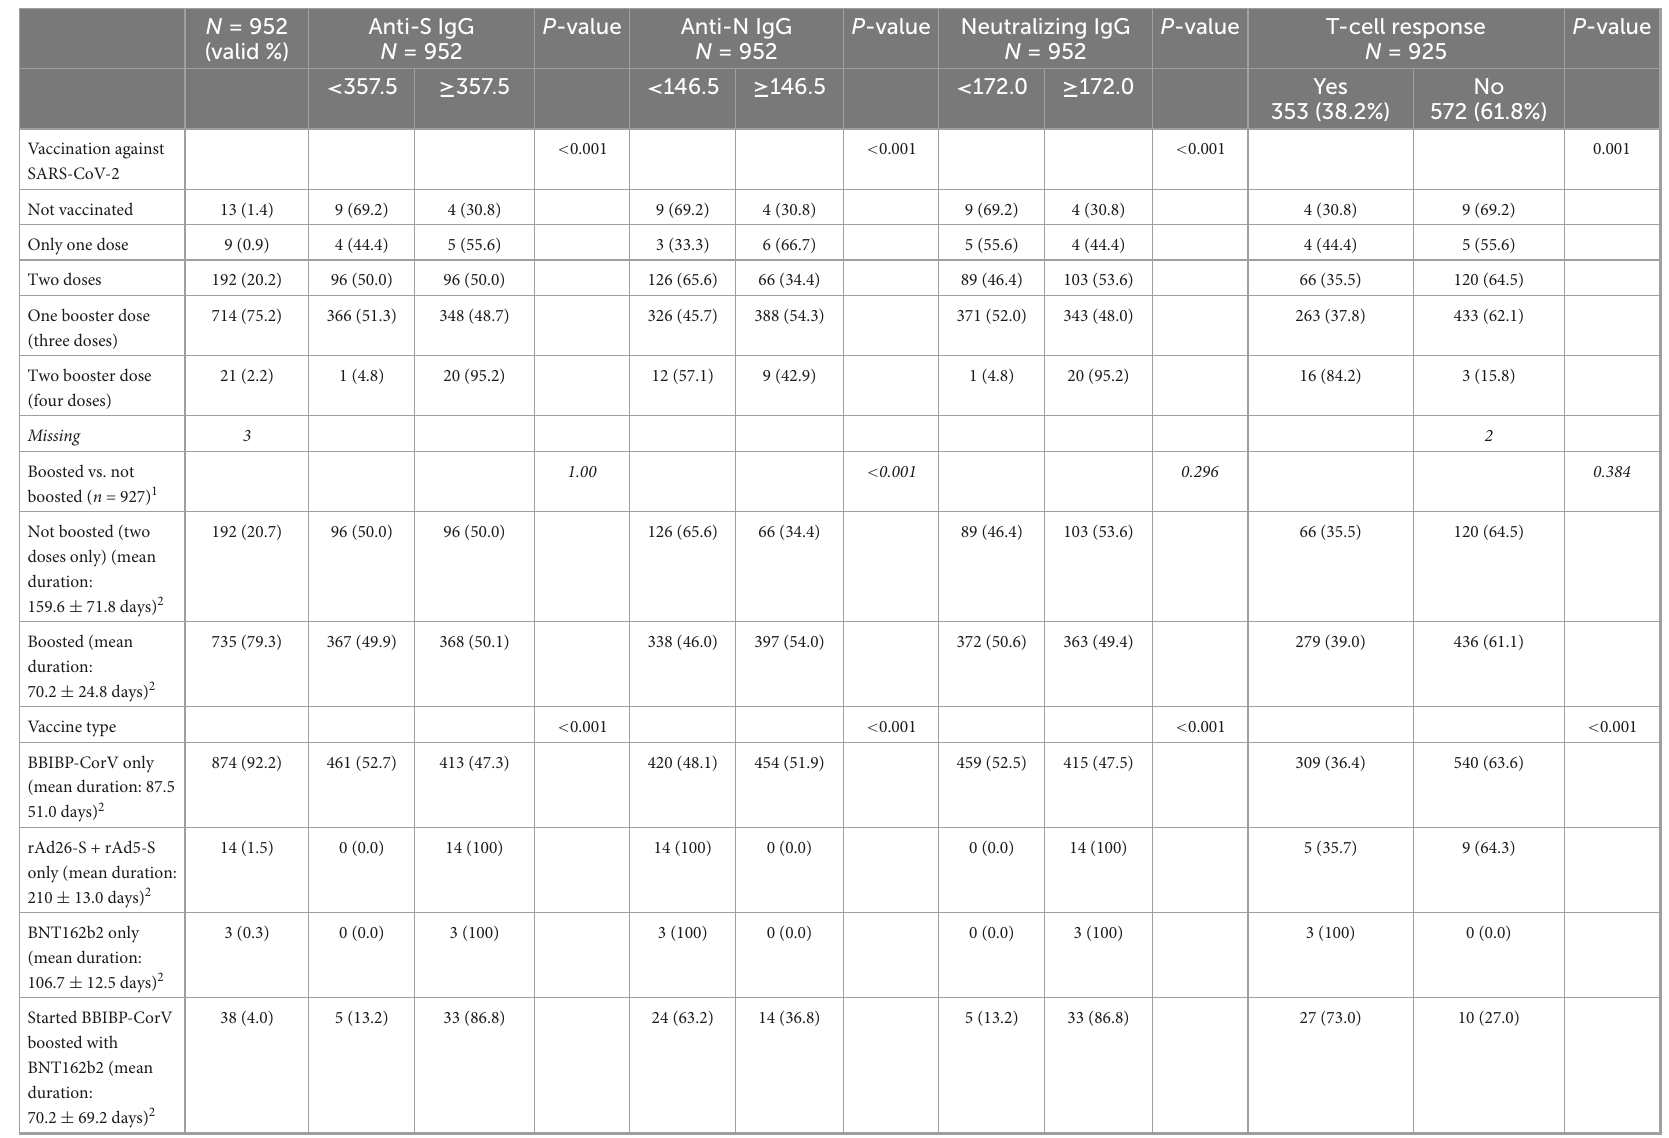
TABLE 3 Distribution of the study population by their vaccination status and history of testing PCR-positive and their correlation with the four-tested immune response biomarkers. N = 952 Anti-S IgG (valid %) N =